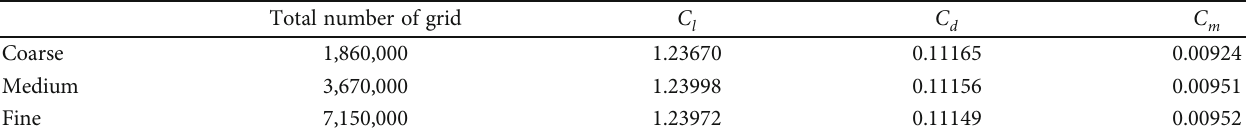
Table 1: Mesh dependency study of tiltrotor wing with a 2 %c GF at α = 8 °